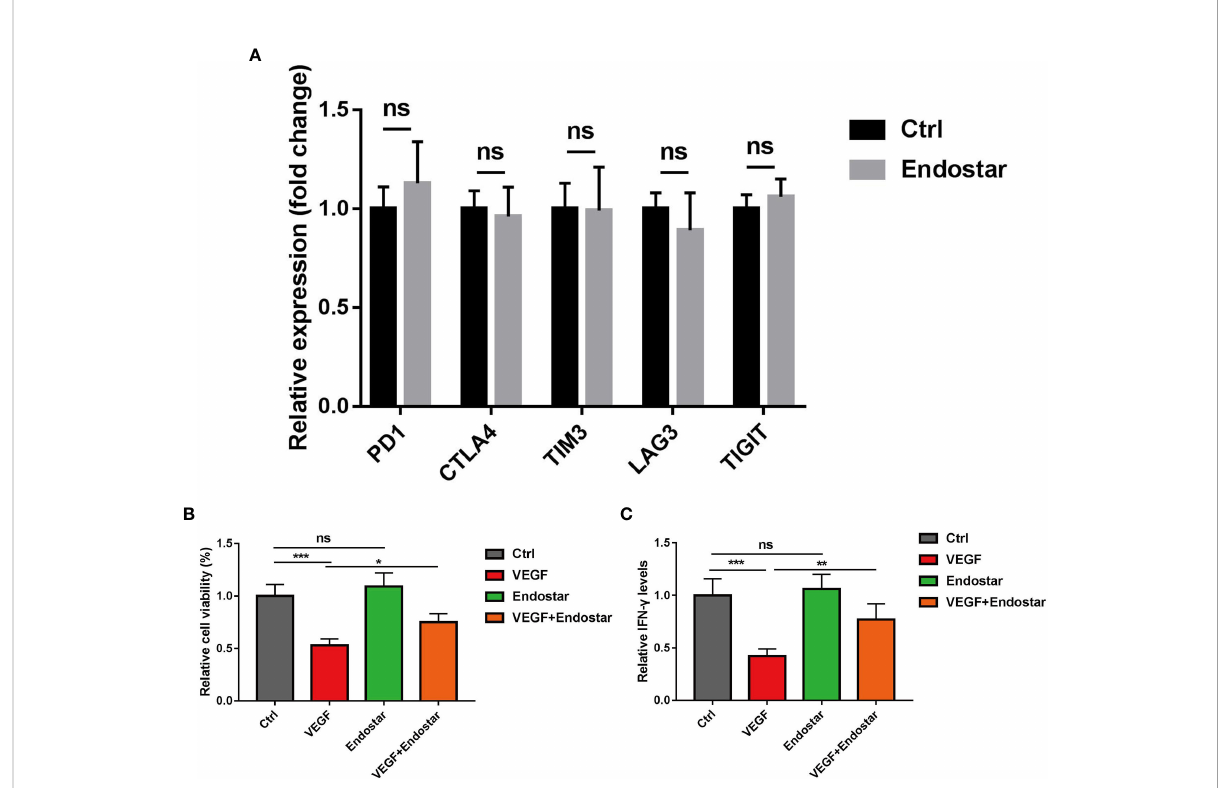
FIGURE 5 Effect of endostatin on vascular endothelial growth factor (VEGF)-mediated T-cell depletion. (A) Endostatin was used to interfere with CD8+ T cells in mice, and RT-qPCR was used to detect the expression changes of markers (PD-1, CTLA4, TIM3, LAG3, TIGIT) related to T-cell depletion in mice. (B) MTT assay Endostar was used to block the inhibition of VEGF on T cell-mediated cell proliferative activity under the intervention of VEGF. (C) ELISA test showed that Endostar was used to block the secretion of T cell-mediated IFN- g by VEGF (ns, P > 0.05; *P< 0.05; **P< 0.01; ***P<